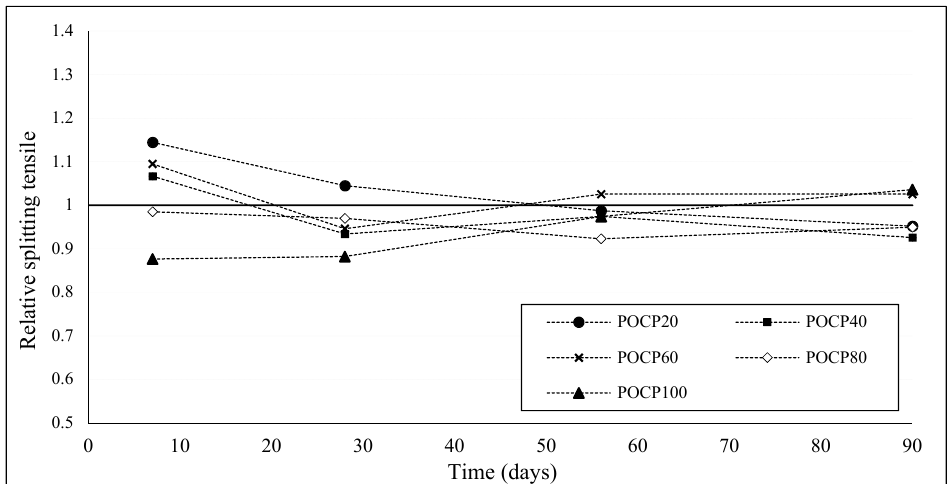
Figure 17. Development of splitting tensile of POCP concrete.